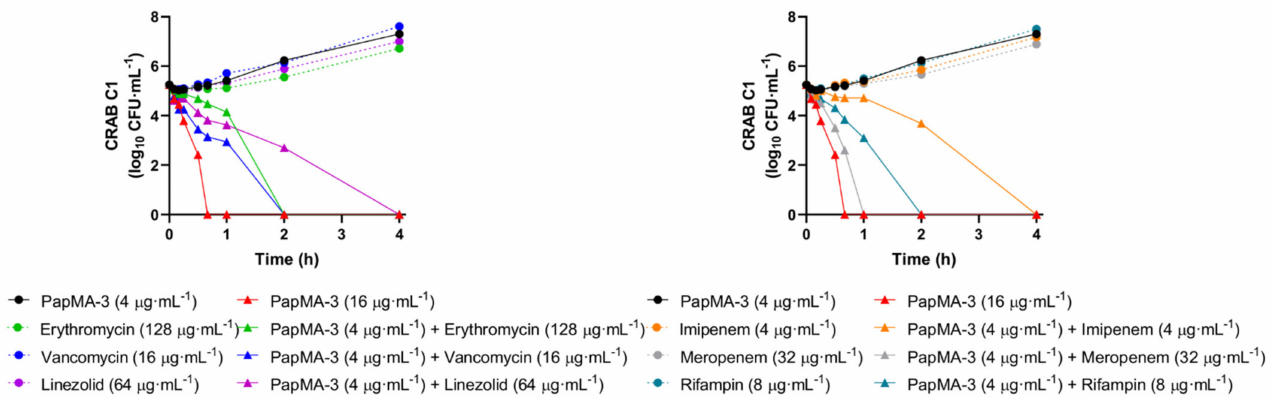
Figure 6. Time-killing curve of PapMA-3 and antibiotics at synergistic concentration against CRAB C1. Y -axis indicates CFU in log scale.